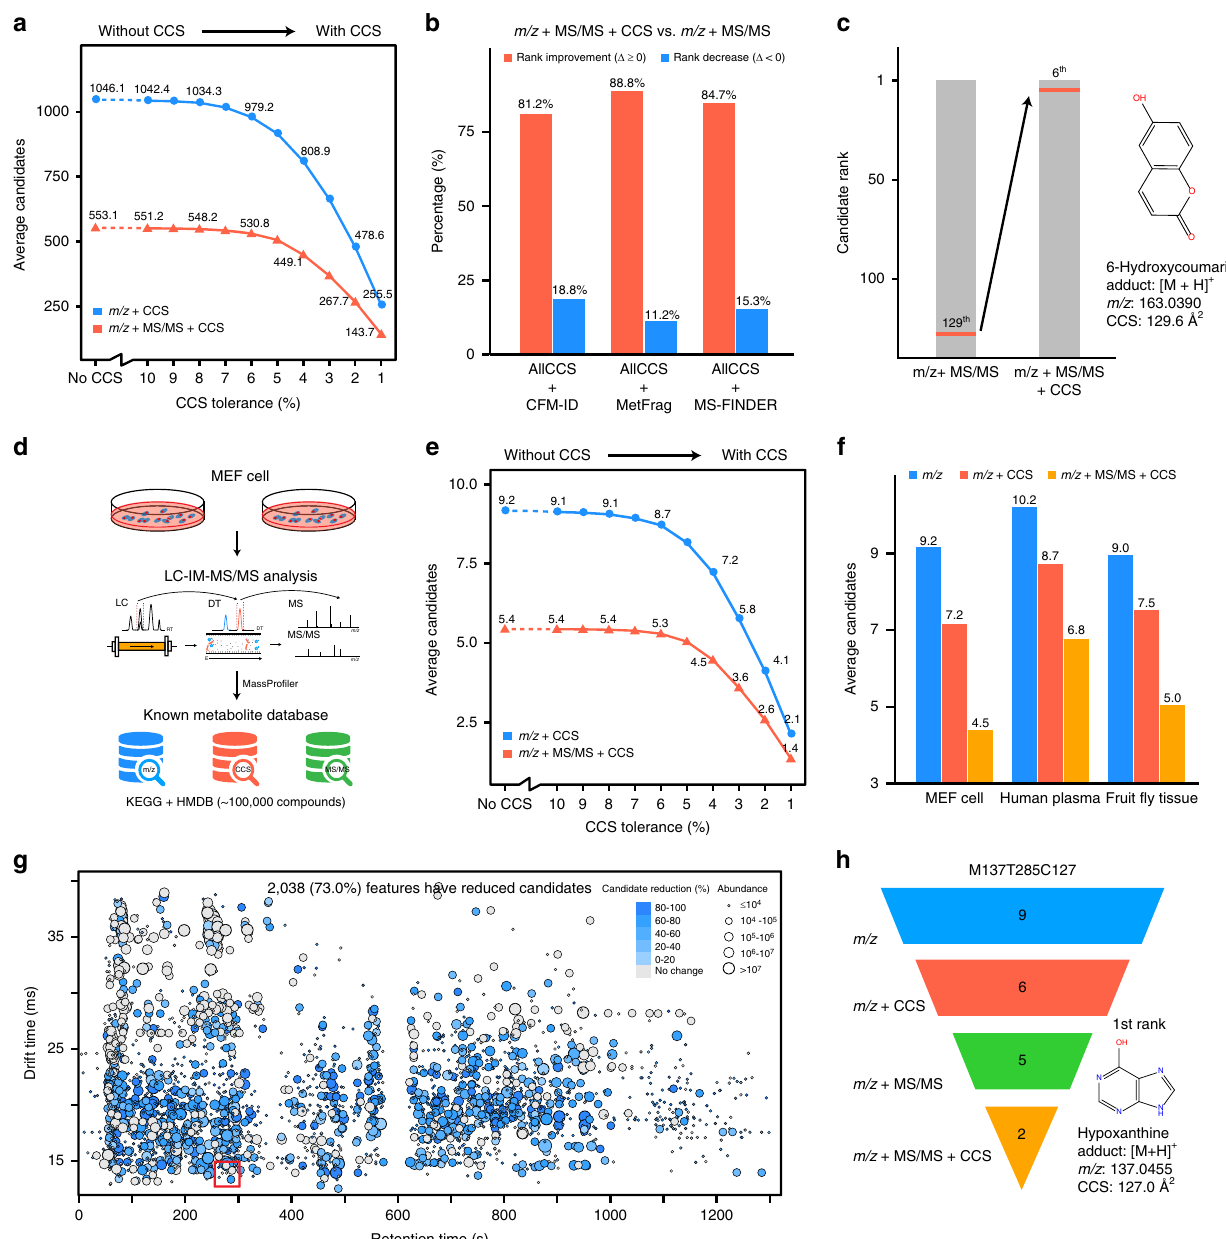
Fig. 4 AllCCS improves known metabolite annotation. a Candidate reduction with addition of CCS match demonstrated using validation set 2; b percentages of rank improvement for correct candidates with addition of CCS match to multi-dimensional match; three in-silico MS/MS prediction tools (CFM-ID, MetFrag, and MS-FINDER) were used to generate predicted MS/MS spectra; c an example of rank improvement for the compound 6- Hydroxycoumarin with addition of CCS match in multi-dimensional match; d schematic illustration of multi-dimensional annotation of metabolites in biological samples; e candidate reduction with addition of CCS match in metabolite annotation of MEF cell samples; f the candidate reductions in different biological samples; the CCS match tolerance was set as 4%; g percentages for candidate reduction with multi-dimensional match for each feature in MEF cell samples; h the hypoxanthine was successfully annotated with multi-dimensional properties; MS-FINDER was used to generate predicted MS/MS spectra for metabolite candidates. Source data are provided as a Source Data fi